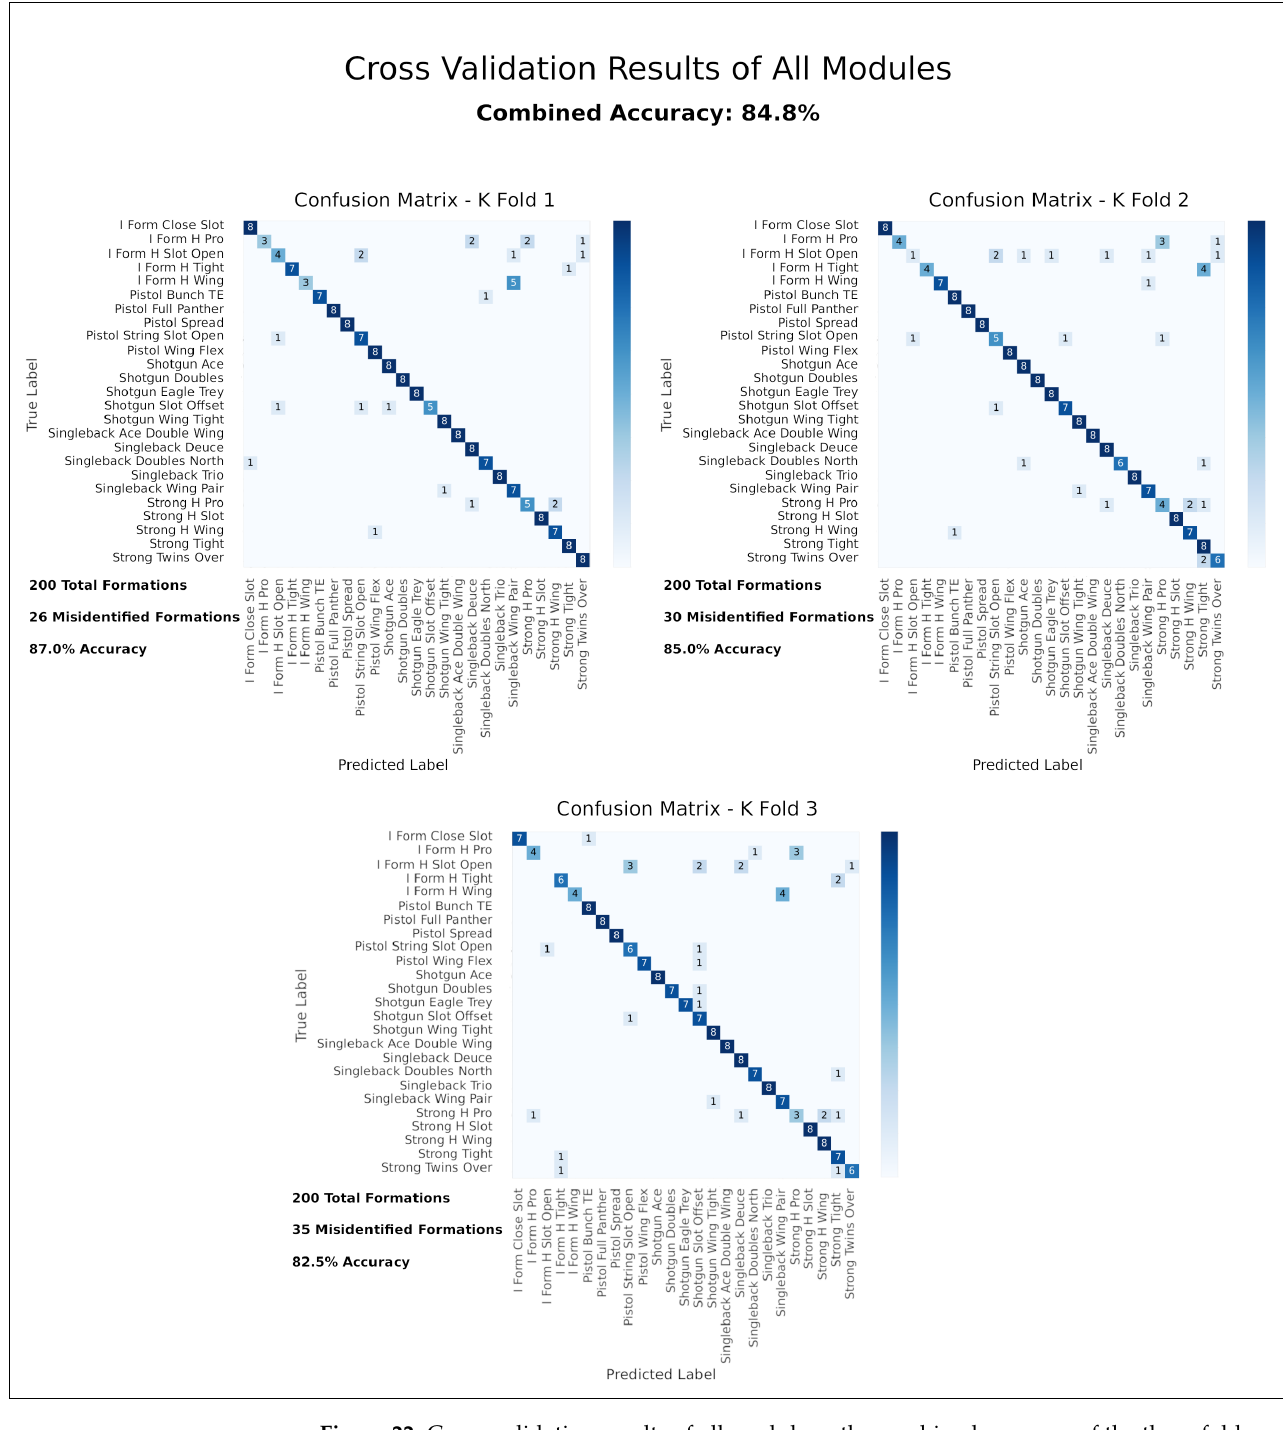
Figure 22. Cross-validation results of all modules—the combined accuracy of the three-fold cross- validation split is 84.8% with a standard deviation of